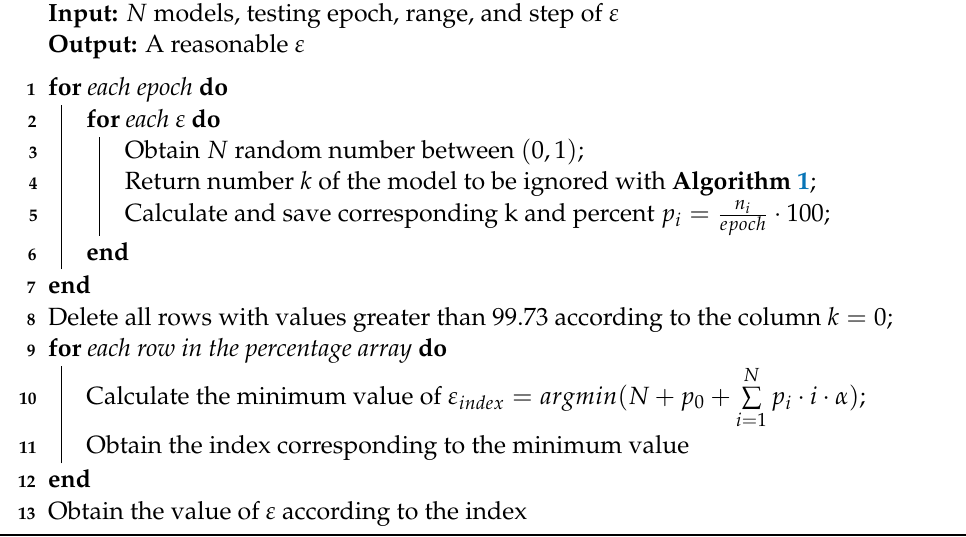
Algorithm 2 Determining of ε in Algorithm 1.